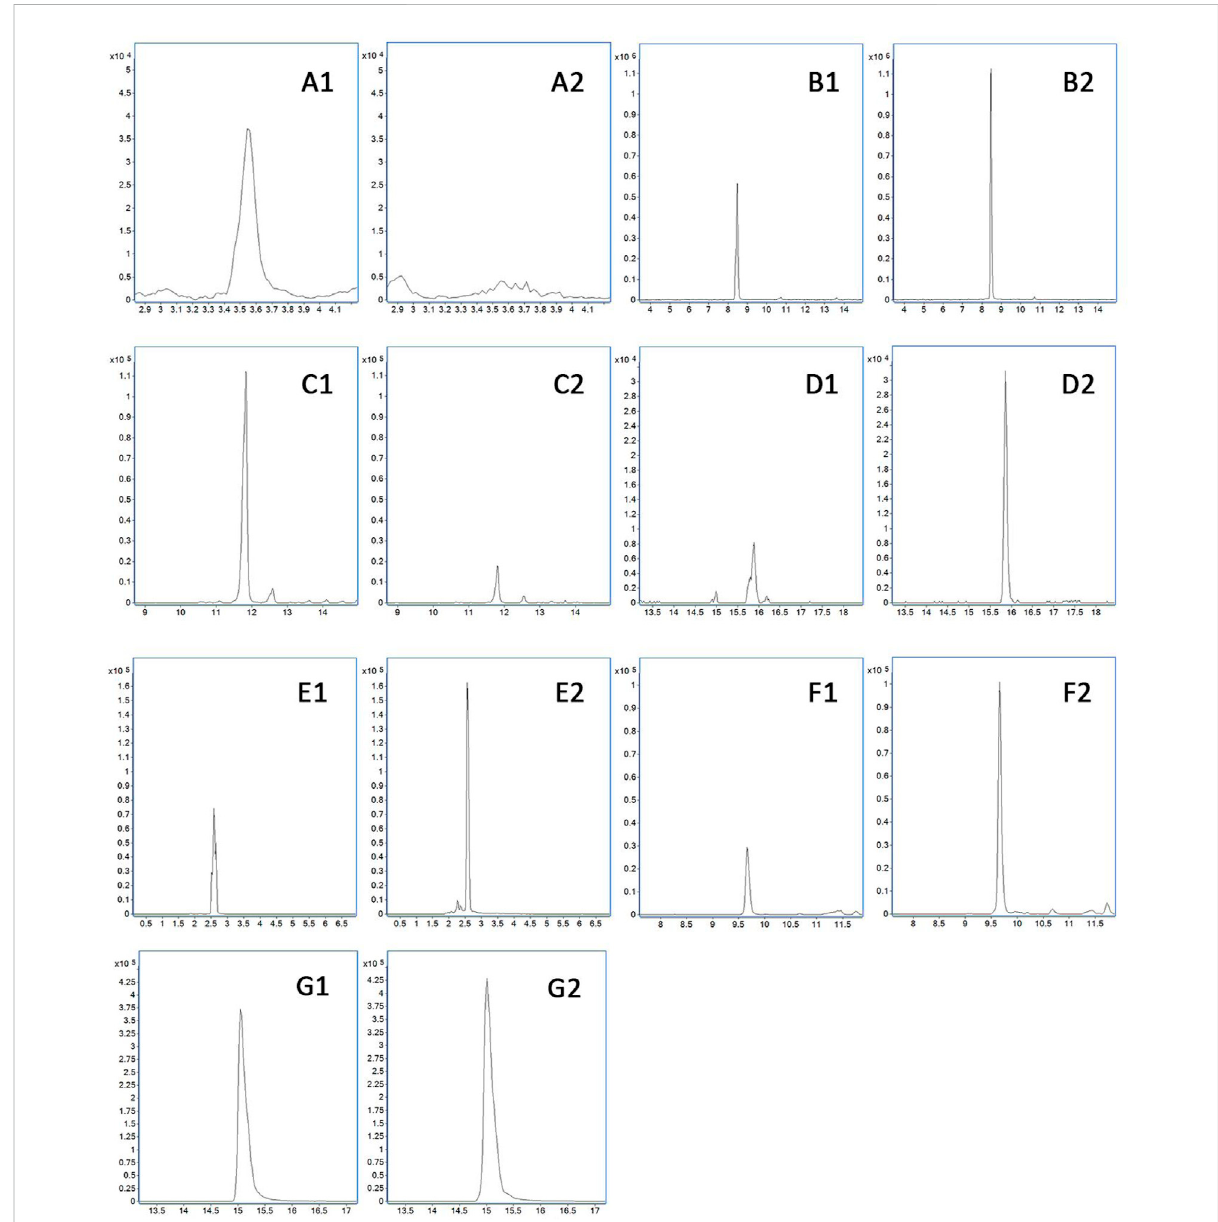
FIGURE 7 Difference of metabolites in the blood. (A) Hypoxanthine oxidation products. (B) Formononetin sulfate. (C) Nobiletin glucuronidation and demethylation product. (D) Glucuronizedcalycosin. (E) Methylatedproductofprotocatechuicacid. (F) 3-Methoxy-caffeine-4-O-sulfate. (G) Caffeic acid-3-O-sulfate. 1 presents the physiological state, and 2 presents the pathological